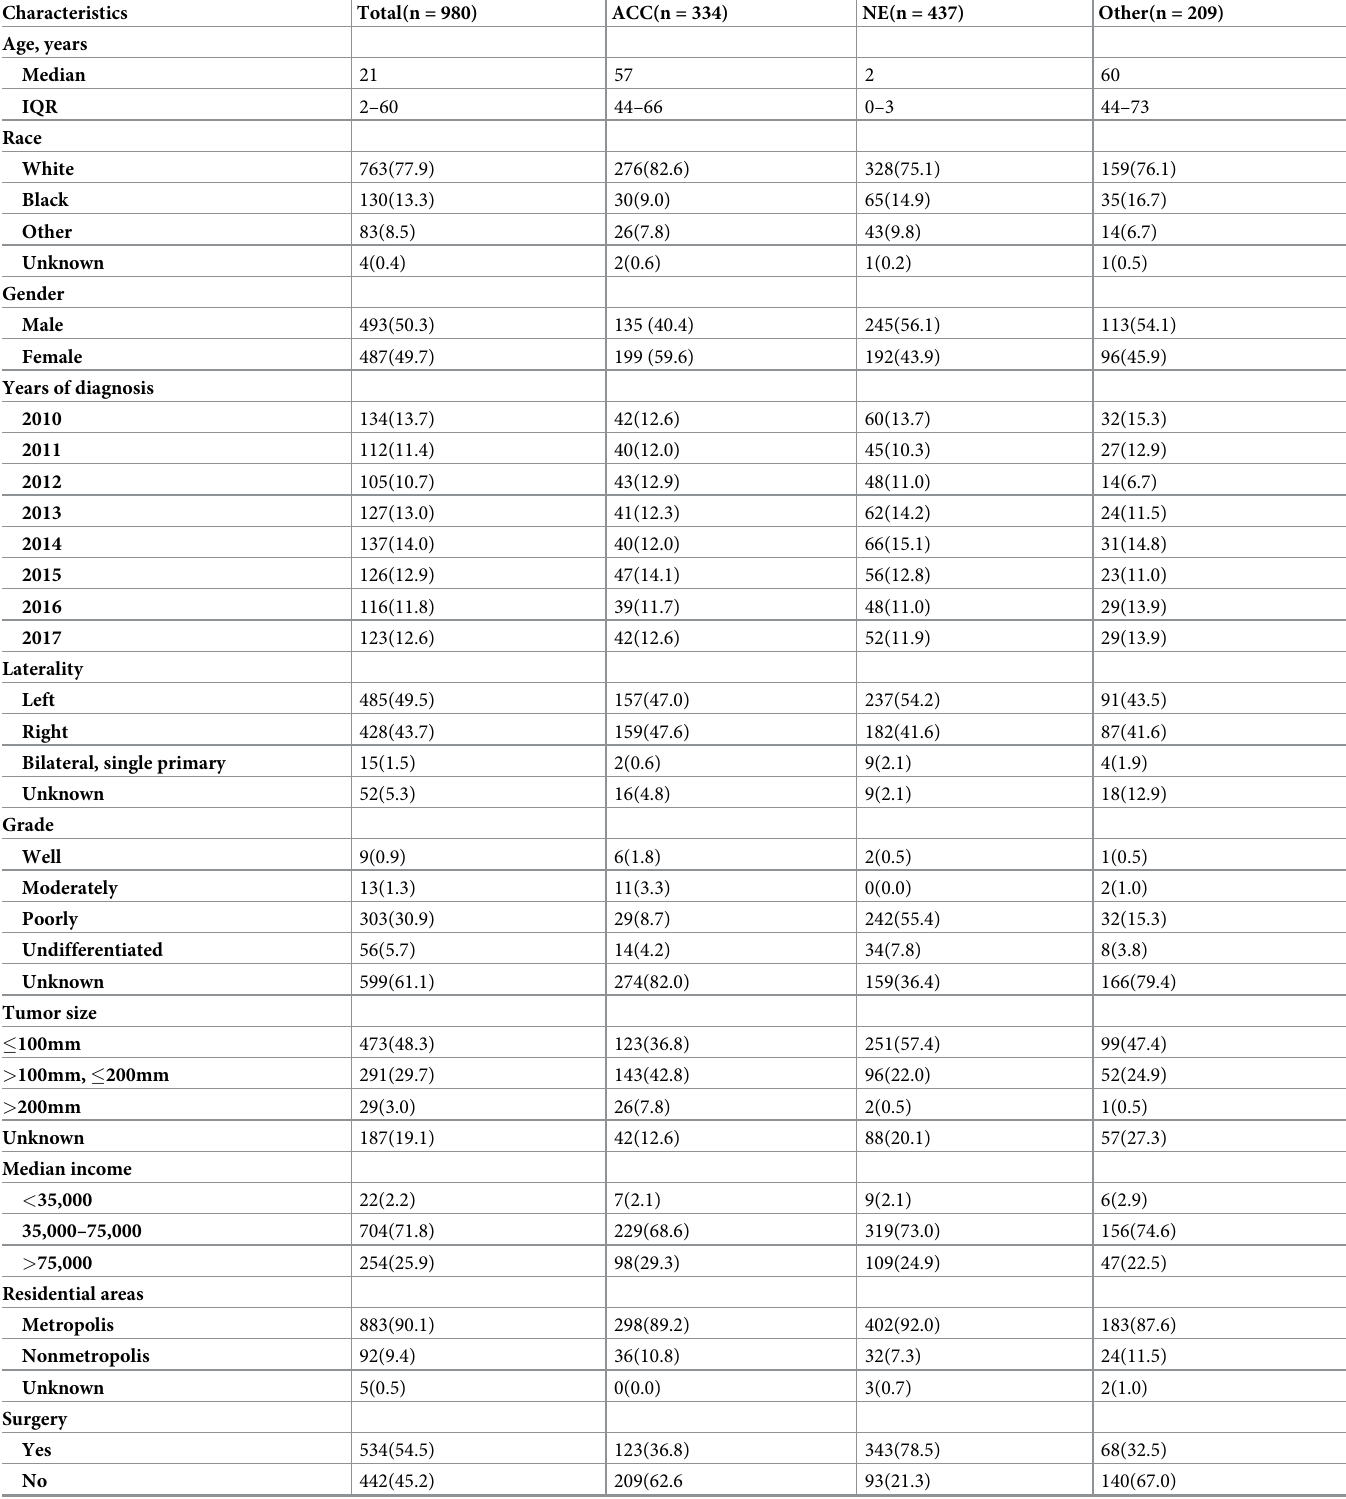
Table 1. Demographical characteristics of